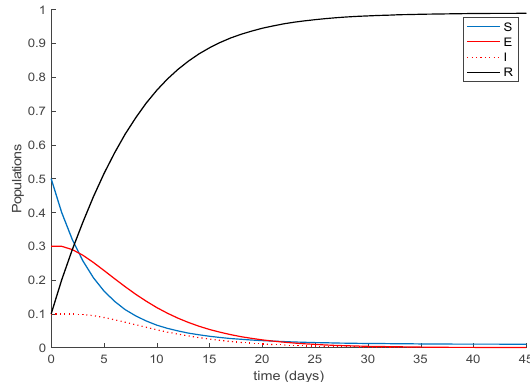
Figure 5. Sequences of populations for Case 1.3 conditions. The vaccination gain K df = 0.1 is employed in this simulation with exponentially fast partial loss of immunity with delay.